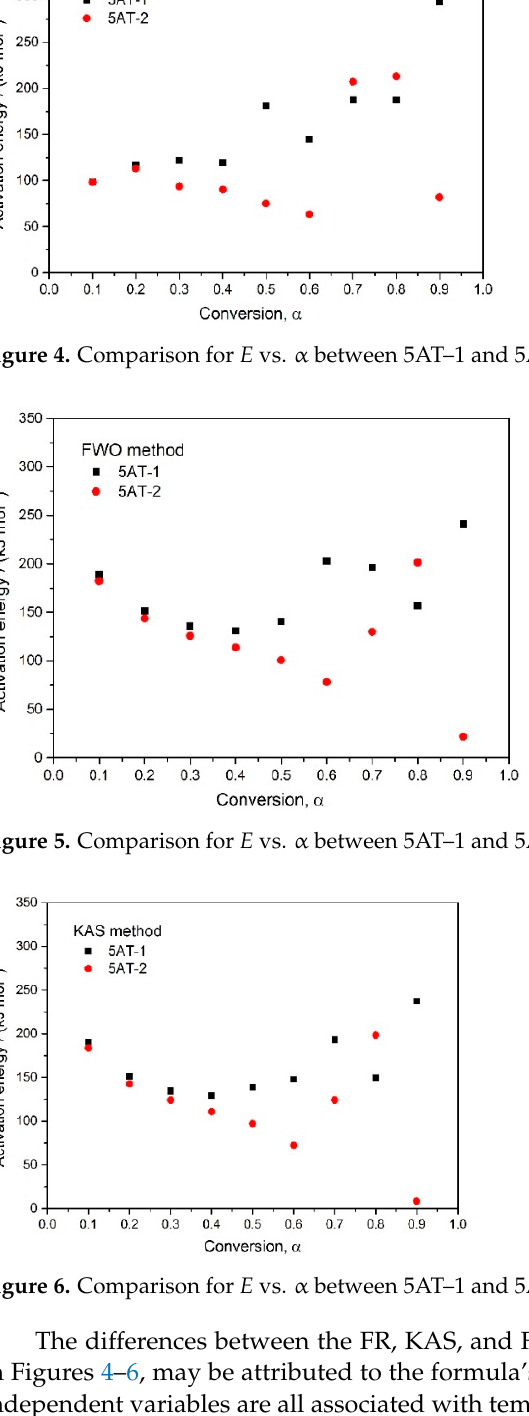
Figure 7. DSC pro fi les of 5AT–1 using four di ff erent heating rates. Figure 8. DSC pro fi les of 5AT–2 using four di ff erent heating rates. Three characteristic temperatures were obtained from the DSC pro fi les, i.e., T 0 , T onset , and T p ; the determination method was same as that used in previous studies [18]. Figure 9 shows the characteristics of the temperature changes ( T o , T onset , and T p ). With the growth of the heating rate, the characteristic temperatures increased. On the other hand, the T o , T onset , and T p of 5AT–2 were lower than those of 5AT–1.